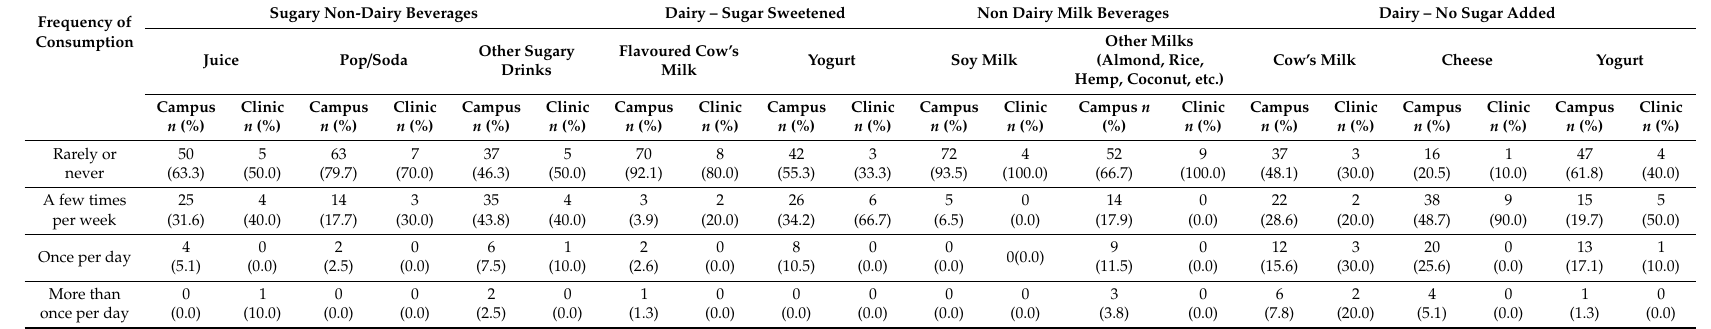
Table 3. Consumption behaviours of food and beverage items that may be associated with increased or reduced dental caries risk among participants in the Campus and Clinic